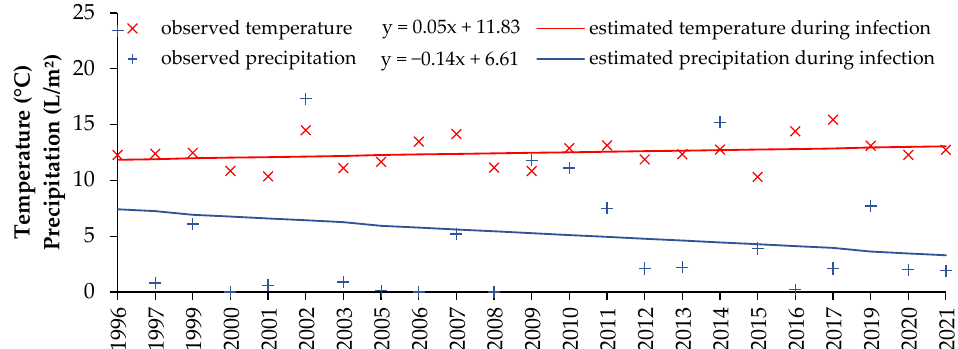
Figure 6. Average temperature (°C; red dots) and total precipitation (L/m 2 ; blue dots) during the annual infection periods and estimated temperature (red line) and precipitation (blue line) of the regression analysis.